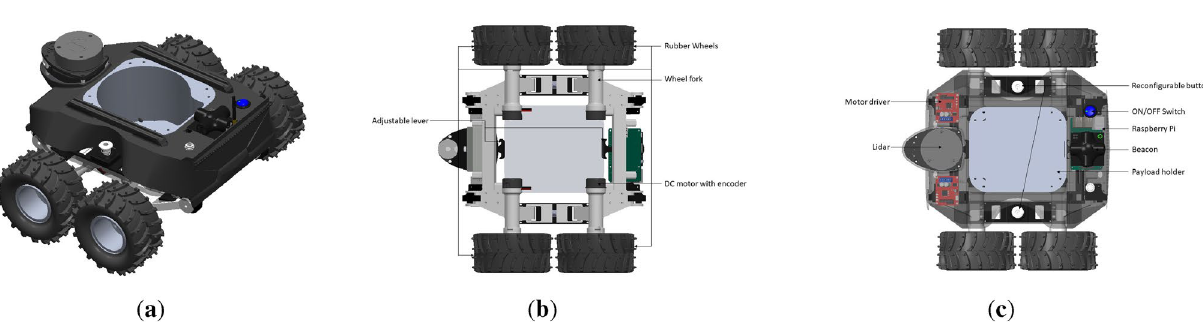
Figure 2. SSD Inception v3 object detection framework.